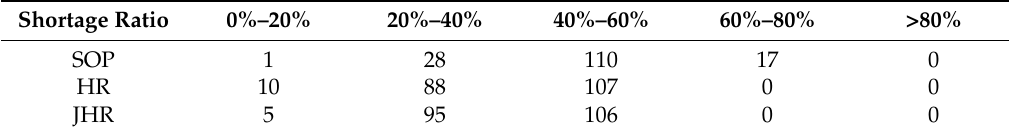
Table 7. Number of different water shortage in ( d , xd ) case.